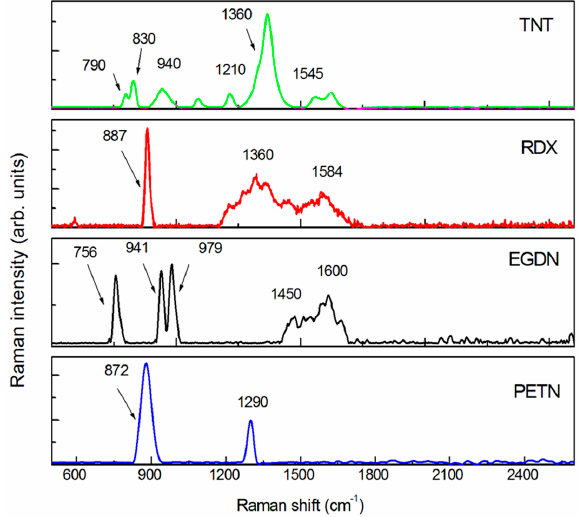
Figure 3. Surface-enhanced Raman spectra of TNT, RDX, EGDN, PETN with the background subtracted. The mass probed by laser is about 200 pg for each substance. The acquisition time is 10 s. The laser power is 150 mW.